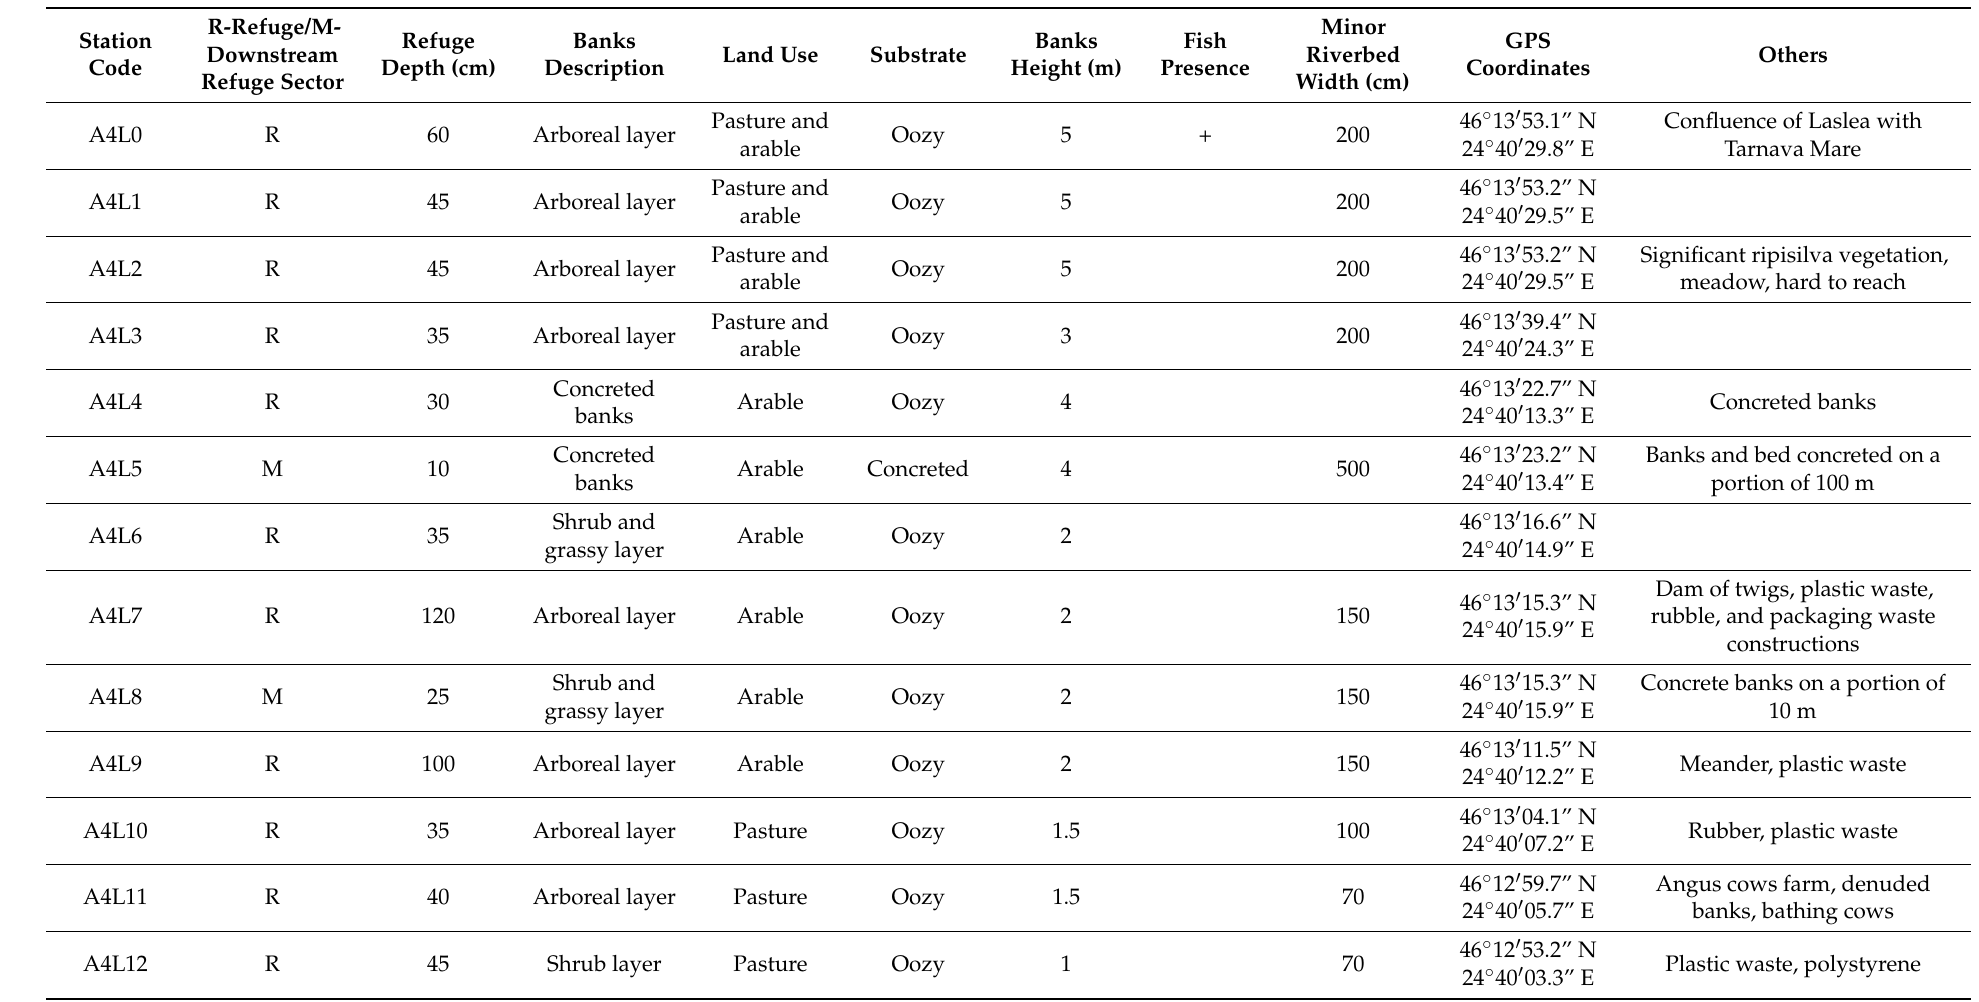
Table A4. Laslea River Habitat